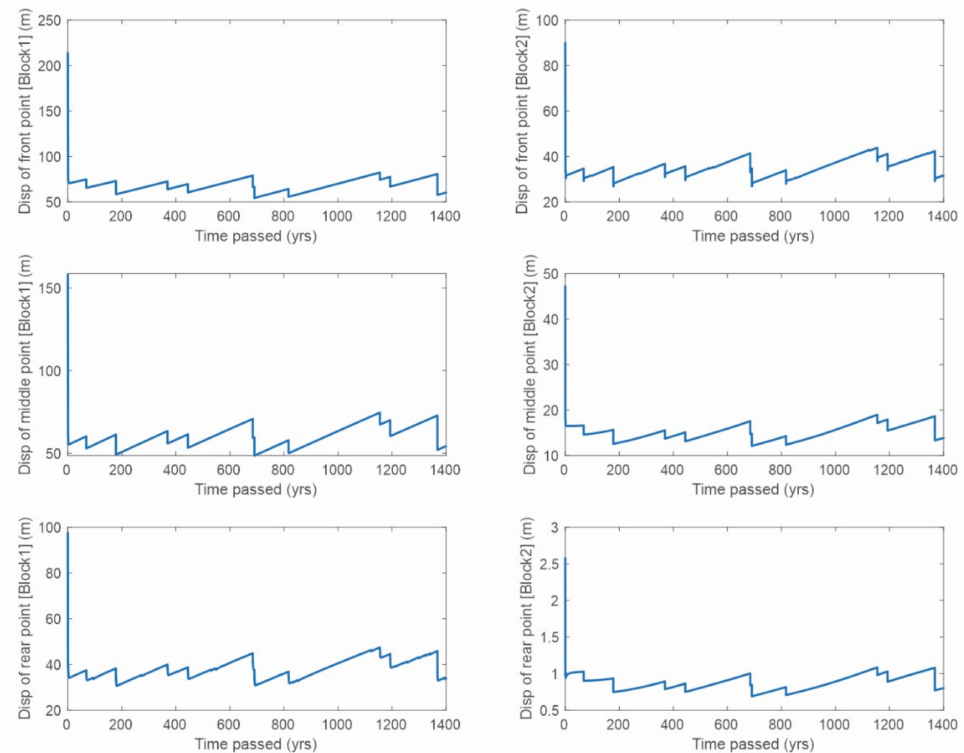
Figure 12. Simulation of several seismic deformation cycles in Kuril subduction zone for generalized keyboard model. Left column of images shows the displacements of two boundary and one middle points of frontal block, right column shows the displacements of the same points of rear block. Stochastic condition for amount of relaxed and accumulated elastic energy was applied. Initial large displacement is caused by stabilization of the numerical scheme and is ignored in further